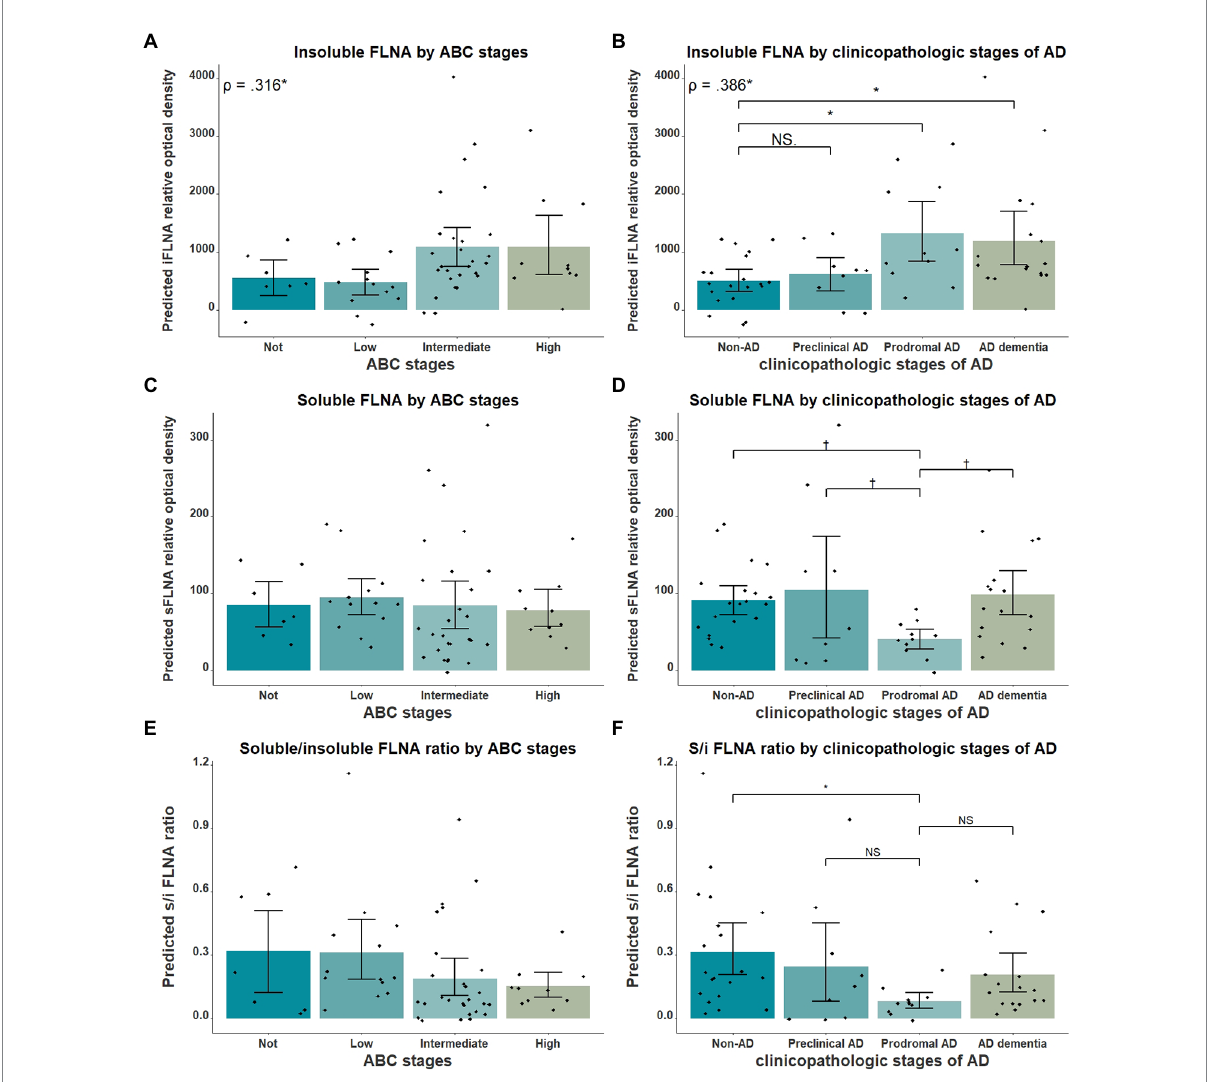
FIGURE 4 FLNA association with ABC scores and clinicopathologic stages of AD. (A) Insoluble FLNA (iFLNA) significantly correlates with ABC scoring, with the “not” score being associated with significantly lower FLNA levels than the “intermediate” score. (B) Insoluble FLNA significantly correlates with clinicopathologic stages of AD, with the non-AD displaying significantly lower FLNA levels than the prodromal AD and the ADD. (C) Soluble FLNA (sFLNA) levels did not vary across the ABC scale. (D) A trend toward lower levels of soluble FLNA at the prodromal AD stage than at any other clinicopathologic stage of AD was found. ( E and F ) Correlation of the soluble/insoluble FLNA ratio with the ABC stages and clinicopathological stages of AD. S/I: soluble over insoluble FLNA ratio. Predicted soluble and insoluble FLNA values shown were calculated by adding the mean to the residual values from age, sex and study batch linear regression. Standardized beta and rho values are displayed to the strength of associations. †: p < 0.1; *: p <